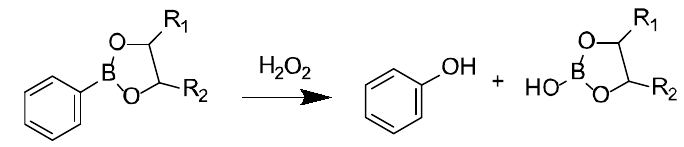
Figure 2. Boronate ester bond cleavage induced by H 2 O 2 .